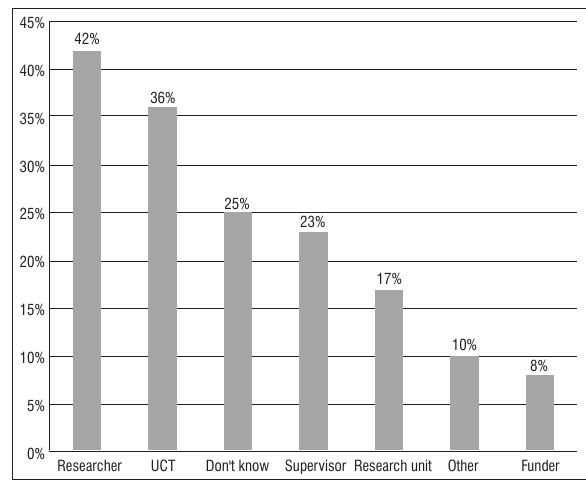
Figure 2: Percentage of respondents who attributed data ownership to each possible